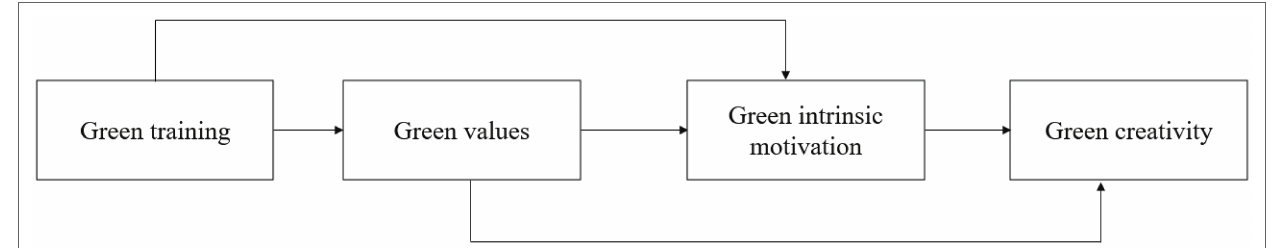
FIGURE 1 | The hypothesized